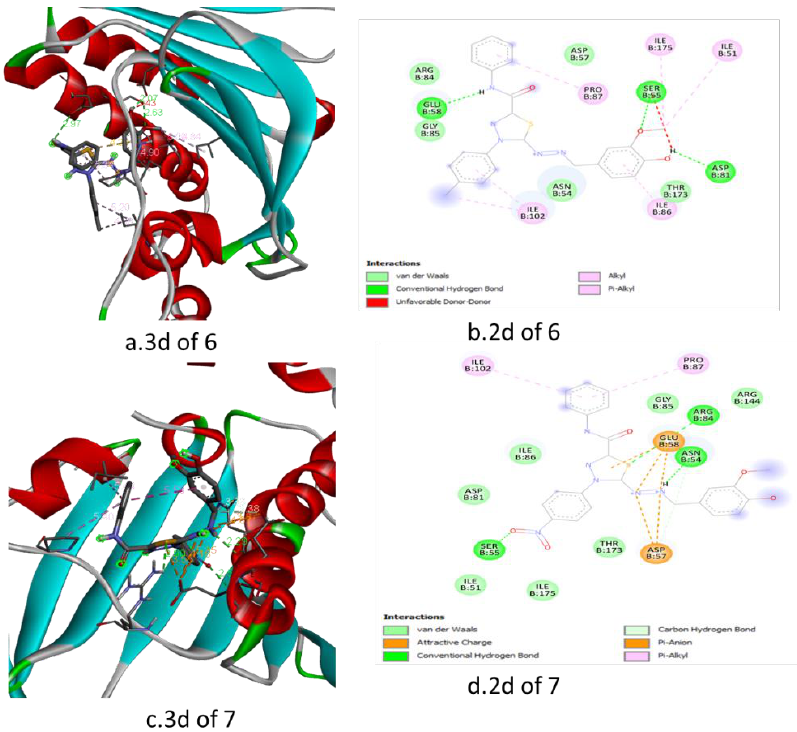
Figure 9. Interaction of the docked compounds 6 and 7 with bacterial DNA gyrase B.